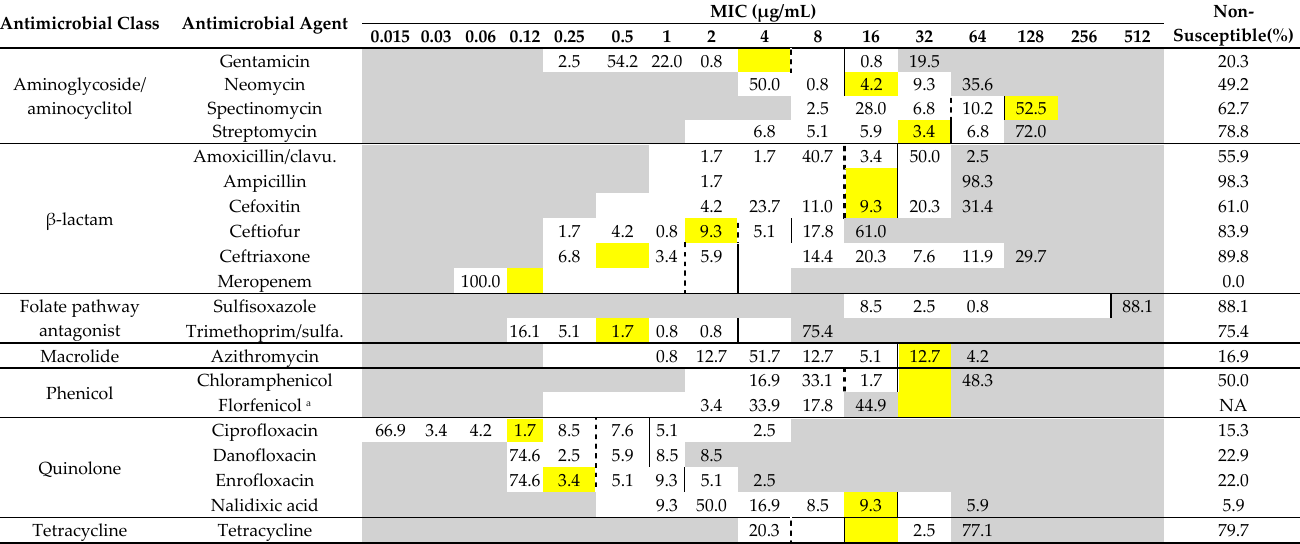
Table 1. Minimum inhibitory concentration for a selection of the most resistant Escherichia coli ( n = 118) isolated from manure from 101 dairy farms in Qu é bec, Canada.